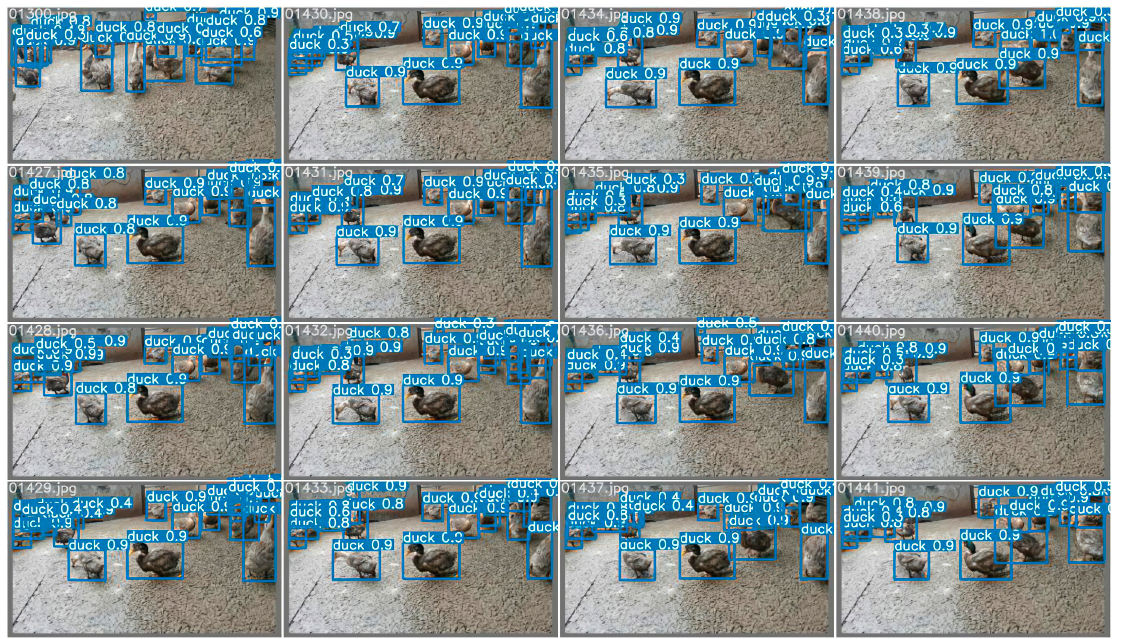
Figure 18. The effect of scheme four. The locations, masking conditions, and individual behaviors of the ducks vary in each extracted frame. The accuracy of sex estimation for detected ducks improved considerably compared to scheme one and scheme two but still does not exceed the results of scheme